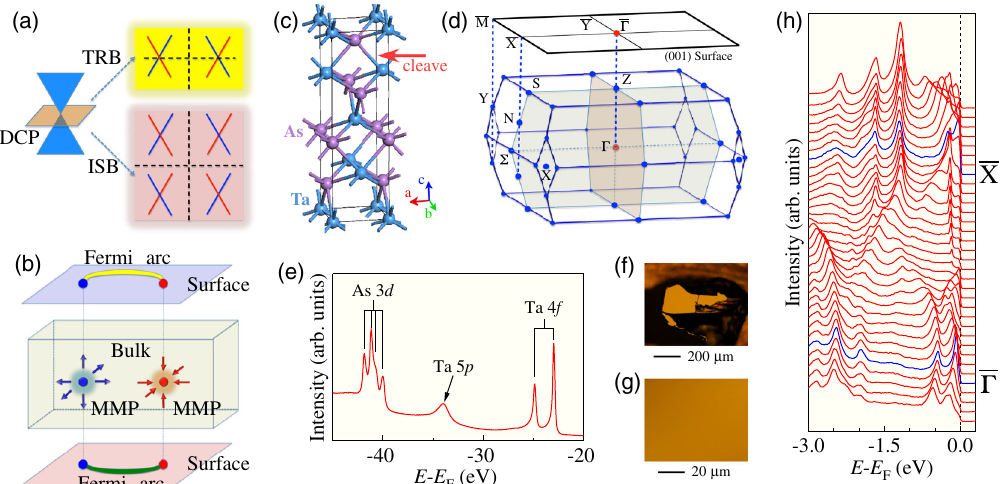
FIG. 1 Weyl semimetal and TaAs single crystal. (a) A 3D Dirac-cone point (DCP) can be driven into Weyl nodes with opposite chirality by either time-reversal symmetry breaking (TRB) or inversion-symmetry breaking (ISB). (b) AWeyl semimetal has Fermi arcs on its surface connecting projections of two Weyl nodes with opposite chirality. A Weyl node behaves as a magnetic monopole (MMP) in momentum space and its chirality corresponds to the charge of the MMP. (c) Crystal structure of TaAs. The arrow indicates that the cleavage occurs between the As and Ta atomic layers, producing two kinds of (001) surfaces with either As- or Ta-terminated atomic layers. (d) Bulk and projected (001) surface BZs are shown, with high-symmetry points indicated. (e) The core-level photoemission spectrum measured with a photon energy h ν ¼ 70 eV shows the characteristic As 3 d , Ta 5 p , and Ta 4 f peaks. Panels (f) and (g) are pictures taken by metallographic microscopy of the cleaved surface of one TaAs sample used in our ARPES measurements. (h) ARPES ¯ Γ ¯ X spectra along - showing highly dispersive and well-defined quasiparticle